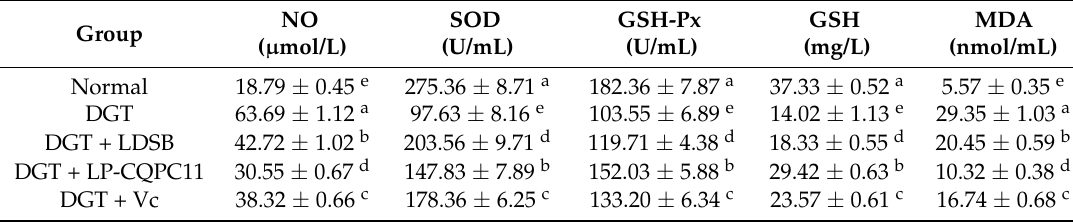
Table 2. The levels of NO, SOD, GSH-Px, GSH, and MDA in serum of mice ( n = 10).